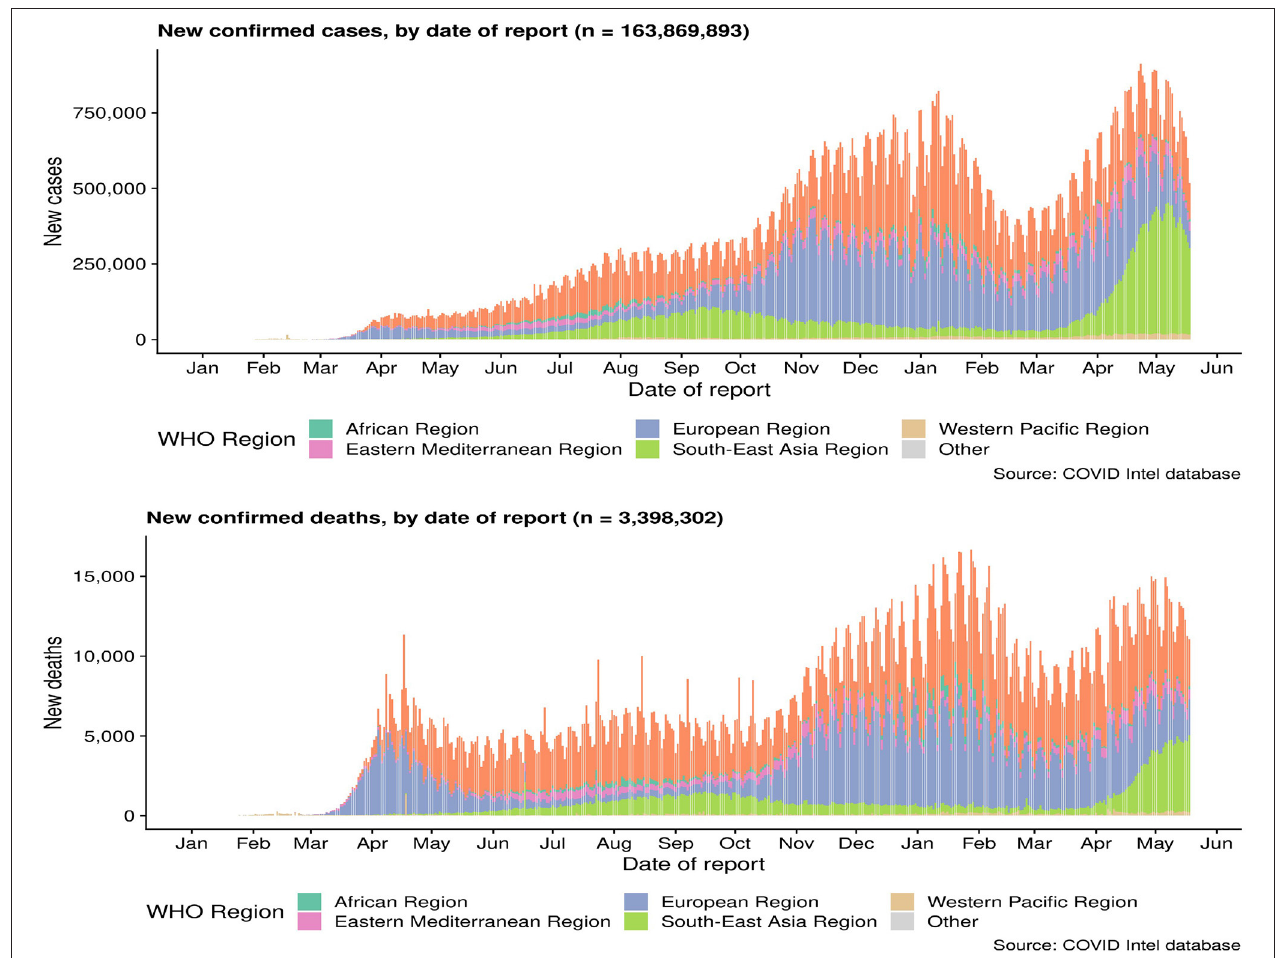
FIGURE 2 | Cumulative confirmed cases and death cases of COVID-19. Data are from the World Health